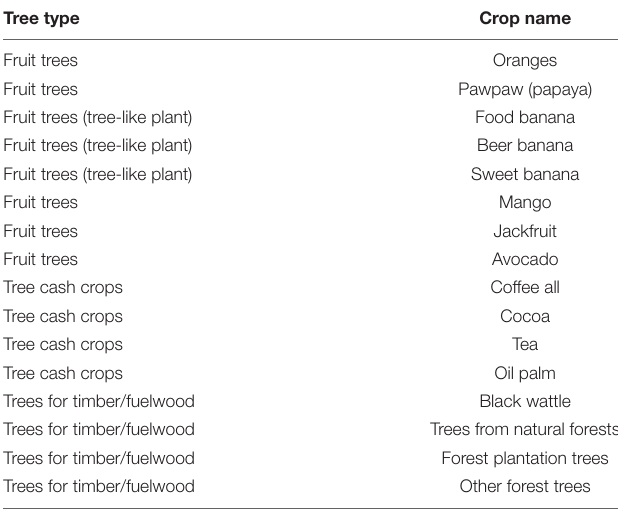
TABLE 1 | Trees on farms classification based on UNPS